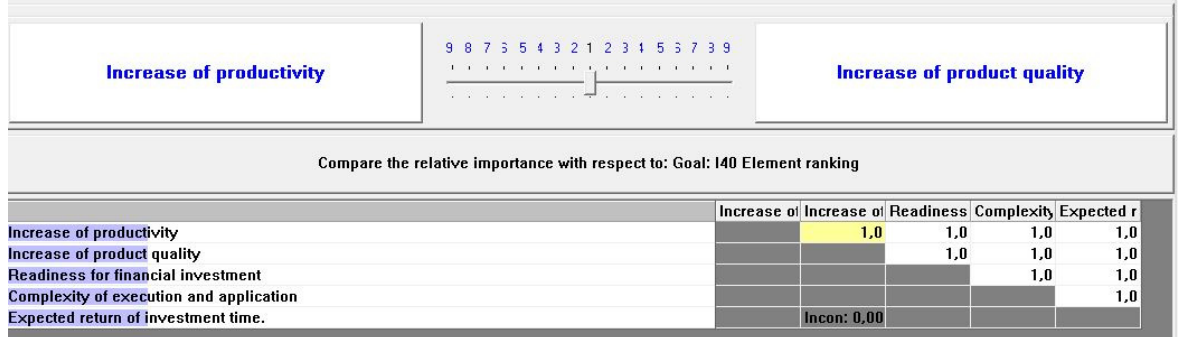
Figure 6. Goals importance definition—case study.